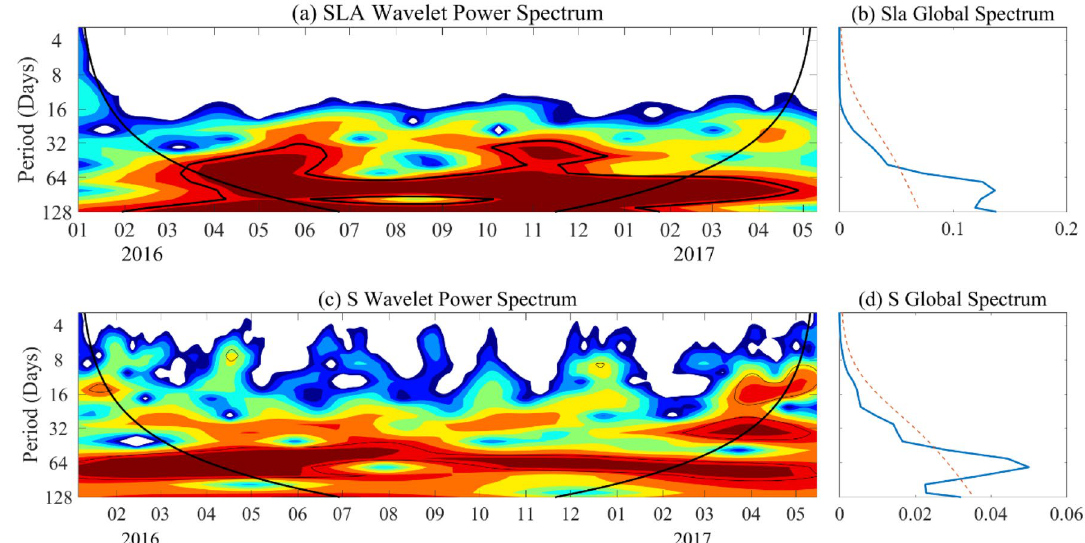
Figure 4. Wavelet power spectrum of SLA and salinity. ( a ) The SLA Wavelet power Spectrum at mooring site 122° E, 23° N from AVISO. The thick black contours represent 95% significance level. ( b ) The corresponding global power spectrum of SLA in Fig. 4a, the red dashed line denotes the 95% significance level. ( c , d ) The same as Figs. 4a and 4b but for salinity averaged between 26.4 and 27.0 Figure 4c,d show the wavelet analysis for the salinity averaged over 26.4–27.0 σ θ , capturing the characteristics of intermediate salinity variability. The wavelet power spectrum showing significant power peaks with intraseasonal variability (ISV) periods of 70–80 days. The ISV signals showed very strong characteristics except in August to September 2016, although the signals before